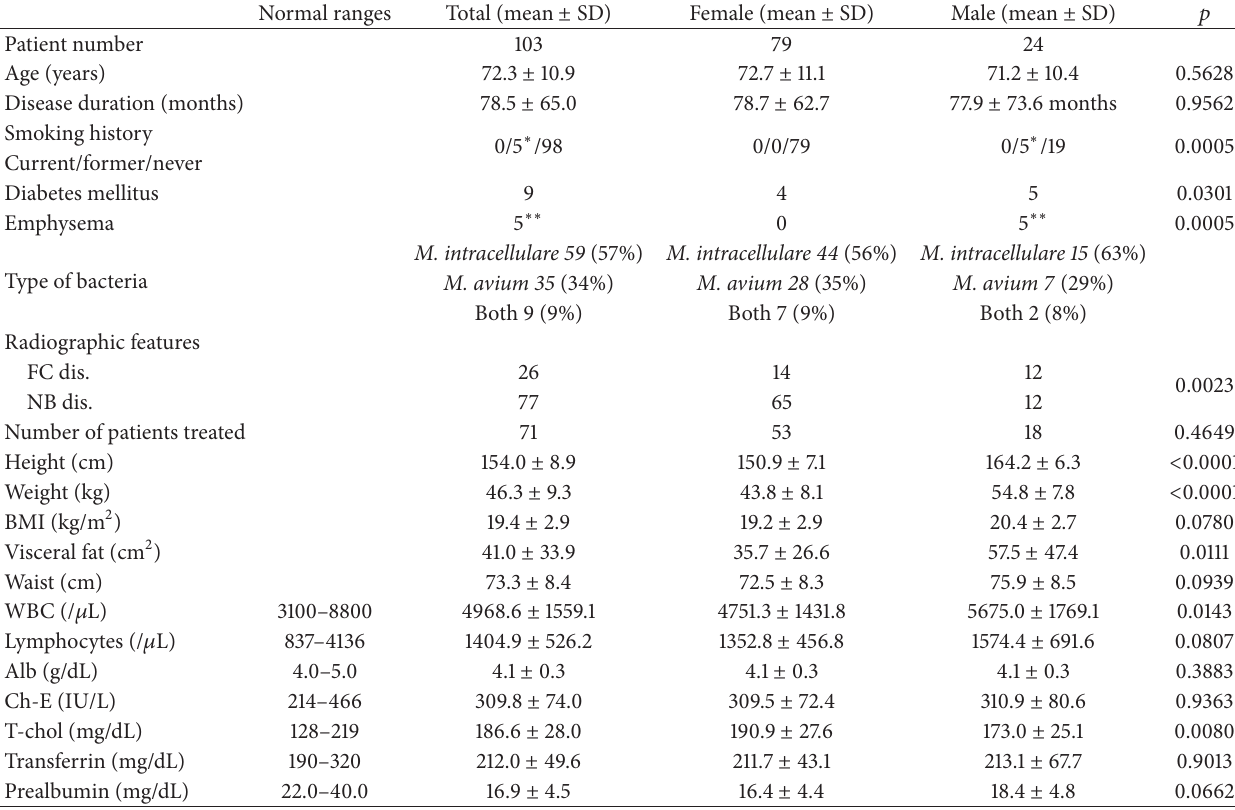
Table 1: Baseline characteristics of patients with MAC lung disease ( 𝑛 = 103 ).